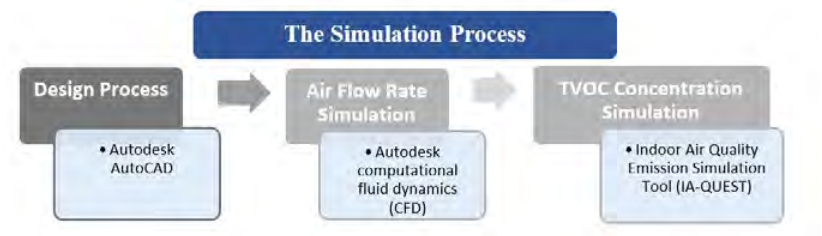
Figure 4. The simulation process concerning the programs